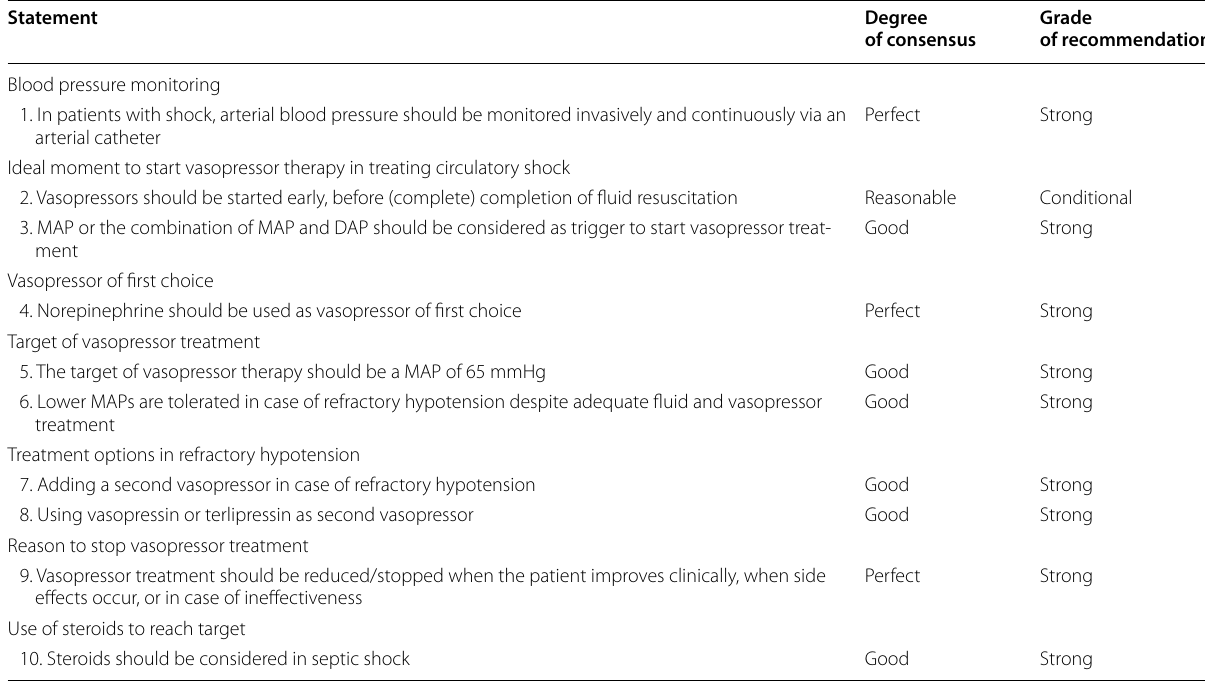
Definitions of degree of consensus and grades of recommendations based on the RAND algorithm. All 34 experts in agreement defined a perfect consensus and